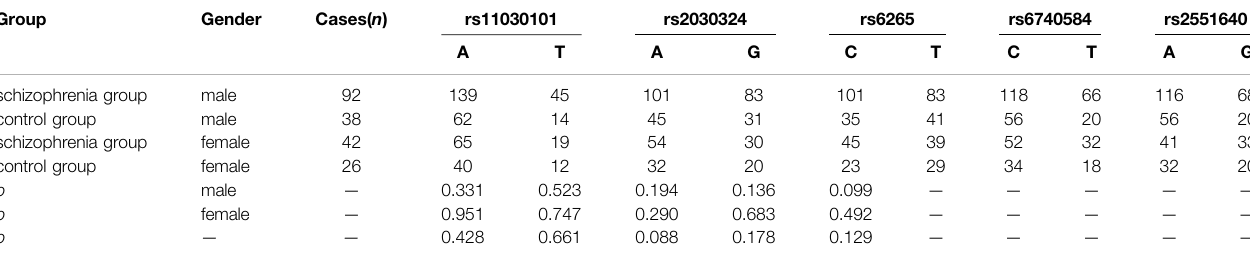
TABLE 5 | Comparison of rs11030101, rs2030324, rs6265, rs6740584, and rs2551640 allele frequencies between the two groups.